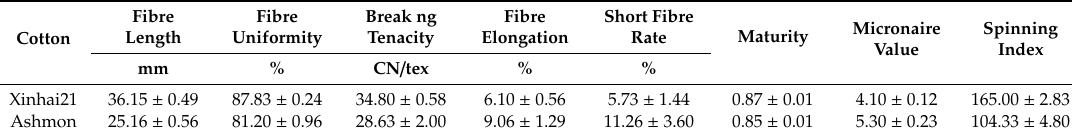
Table 1. Average cotton fibre quality parameters from 2014 to